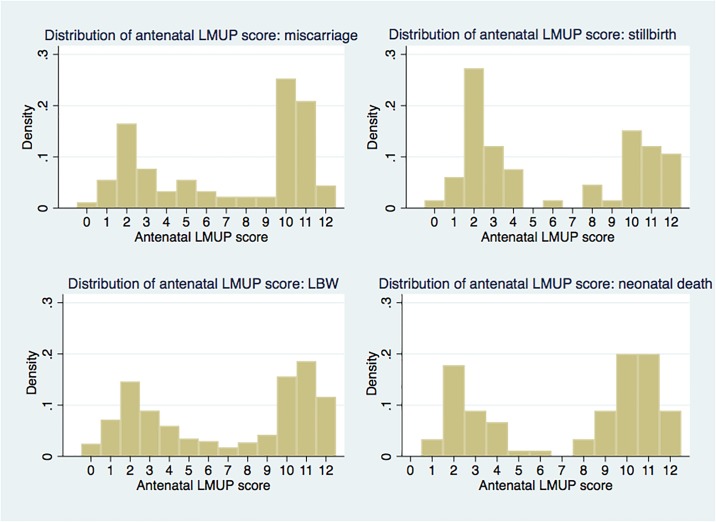
Distribution of antenatal LMUP score by miscarriage, stillbirth, low birthweight and neonatal death.